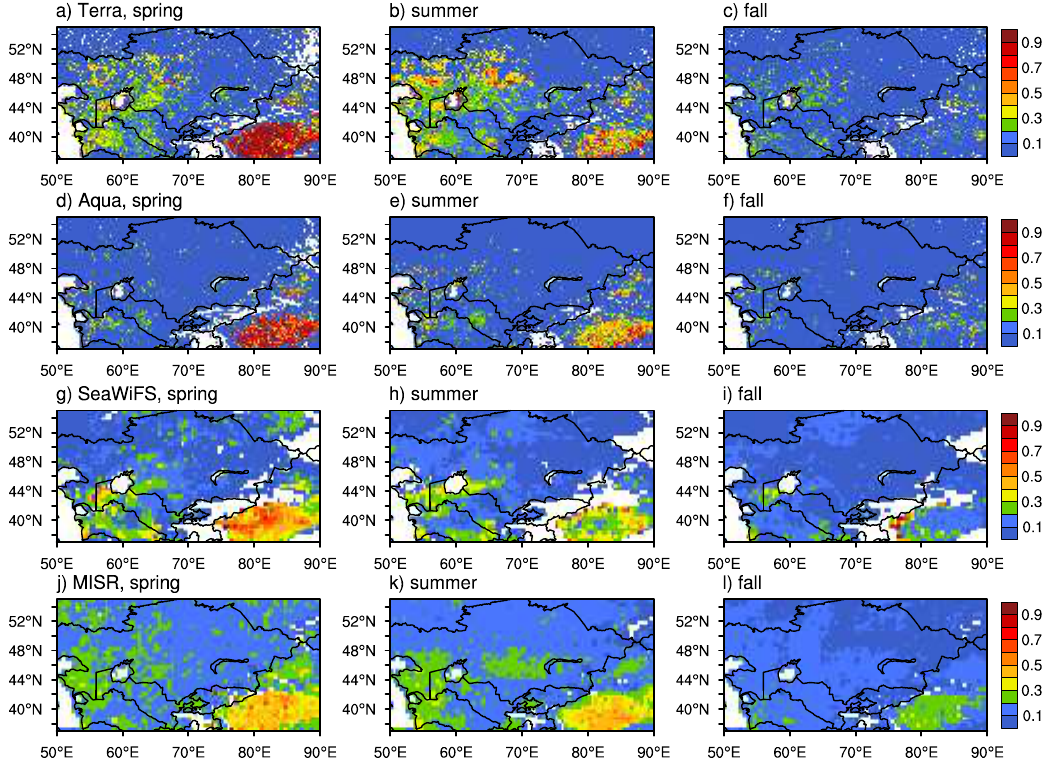
Figure 4. Seasonal mean of DOD in the spring, summer, and fall during the 2003–2007 period from MODIS onboard Terra ( a , b , and c )/Aqua ( d , e , and f ), SeaWiFS ( g , h , and i ), and MISR ( j , k , and l ). White indicates no retrievals available. Atmosphere 2018 , 9 , x FOR PEER REVIEW